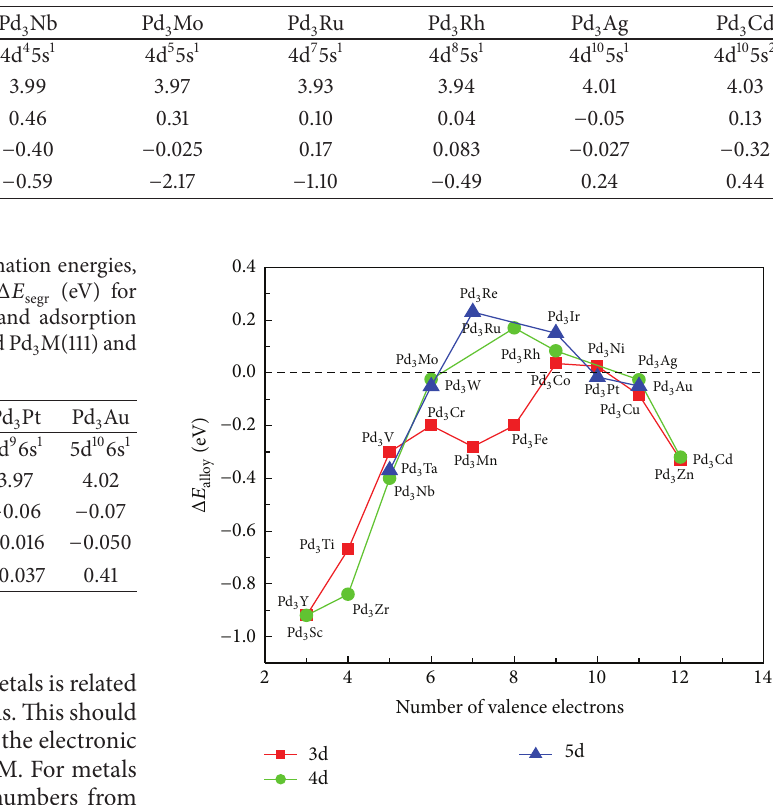
(eV), surface segregation energies of Pd, Δ𝐸 alloy